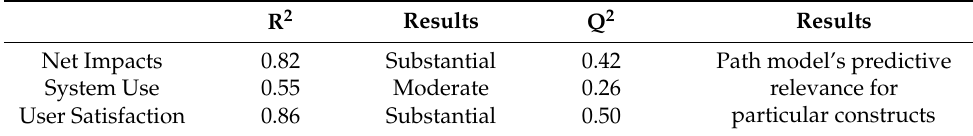
Table 4. Table 4. R 2 and Q 2 of the endogenous latent